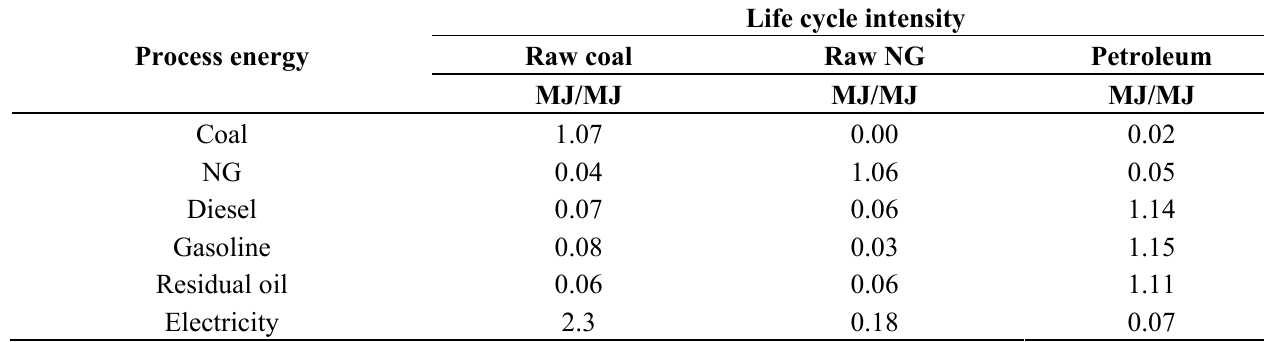
Table 1. Life cycle primary energy intensity for process energy in China.